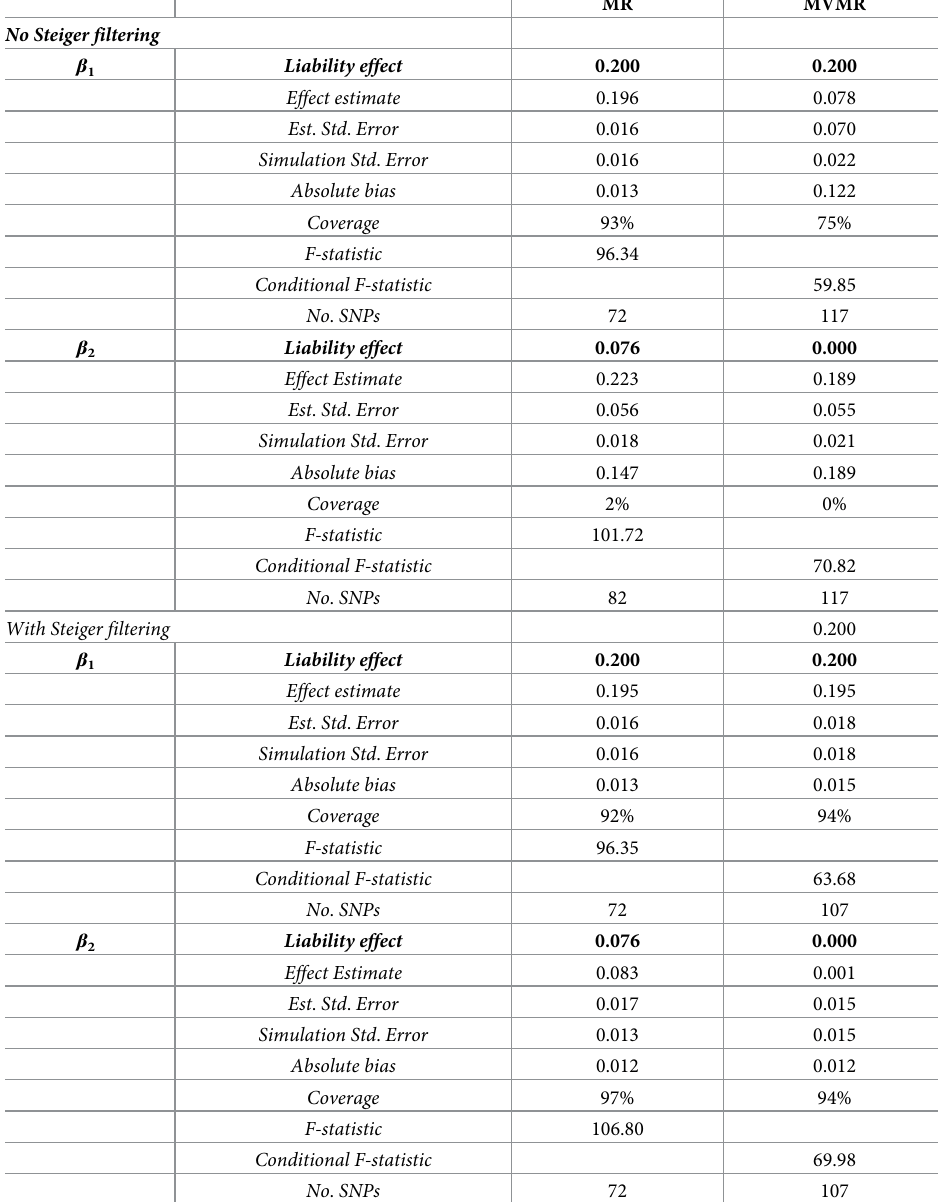
Table 2. Simulation results for multiple time points with a causal effect from the outcome to the later time